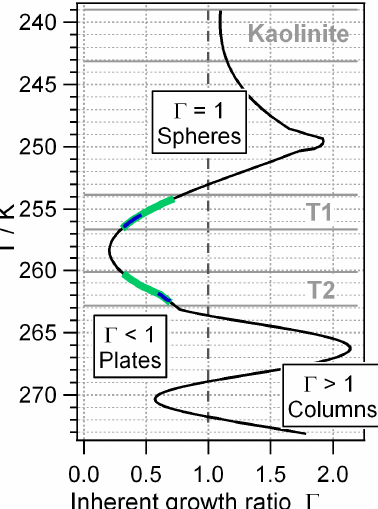
Figure 6. Inherent growth ratio Γ as a function of temperature (adapted from Chen and Lamb (1994)). The notation ‘columns, spheres, plates’ refers to the shape the particle would attain if it were nucleated and grown primarily within that temperature range. The grey horizontal lines show temperature regimes for simulations where (i) IN composed of kaolinite nucleate ice and (ii) other IN are expected to nucleate ice (T1, T2). The blue and green shading within T1 and T2 marks the range where nucleation occurs if the 1 θ or the deterministic schemes, is applied, respectively.